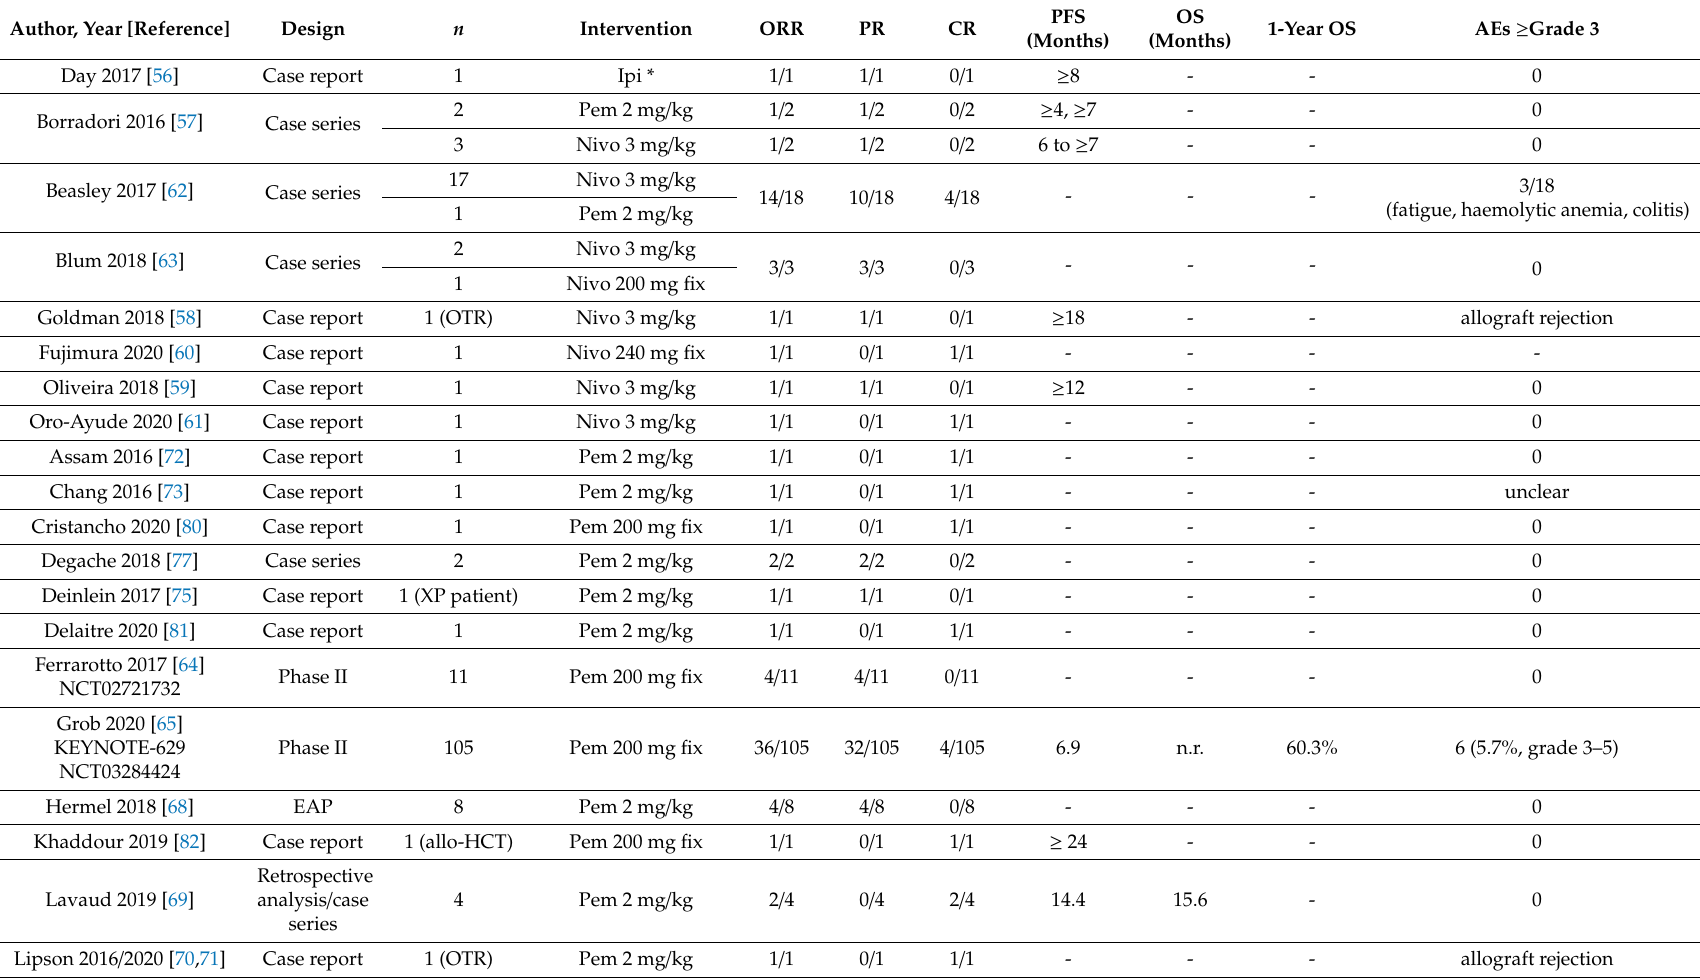
Table 1. Immune checkpoint blockade in cutaneous squamous cell carcinoma (cSCC)